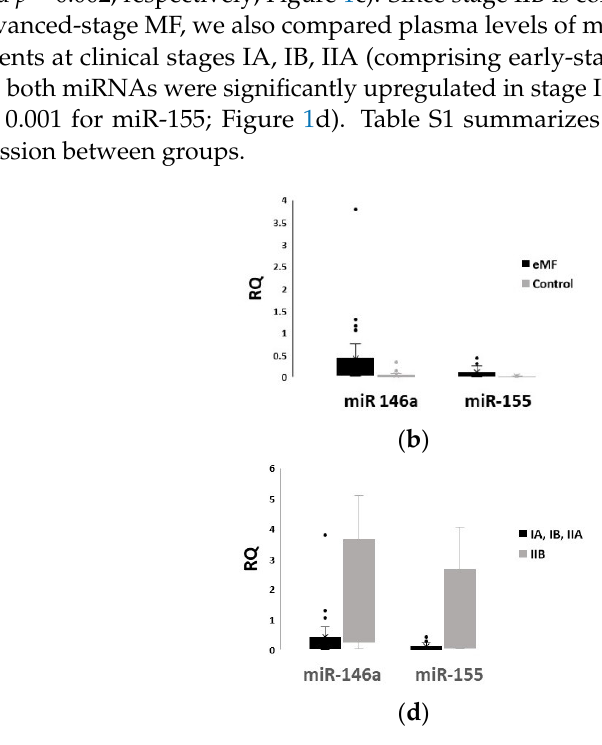
Figure 1. Plasma levels (mean ± SD) of miR-146a and miR-155 in patients vs. control ( a ), in eMF patients vs. control ( b ), in early MF (eMF) vs. advanced MF (aMF) patients ( c ) and in clinical stages IA, IB, IIA vs. IIB ( d ).